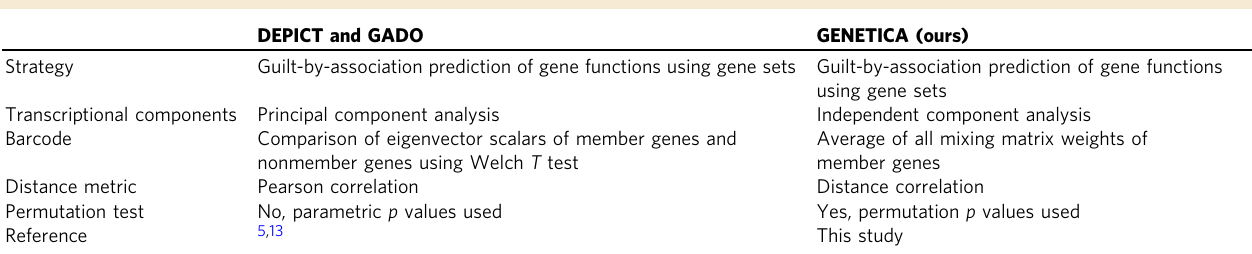
Table 1 Guilt-by-association